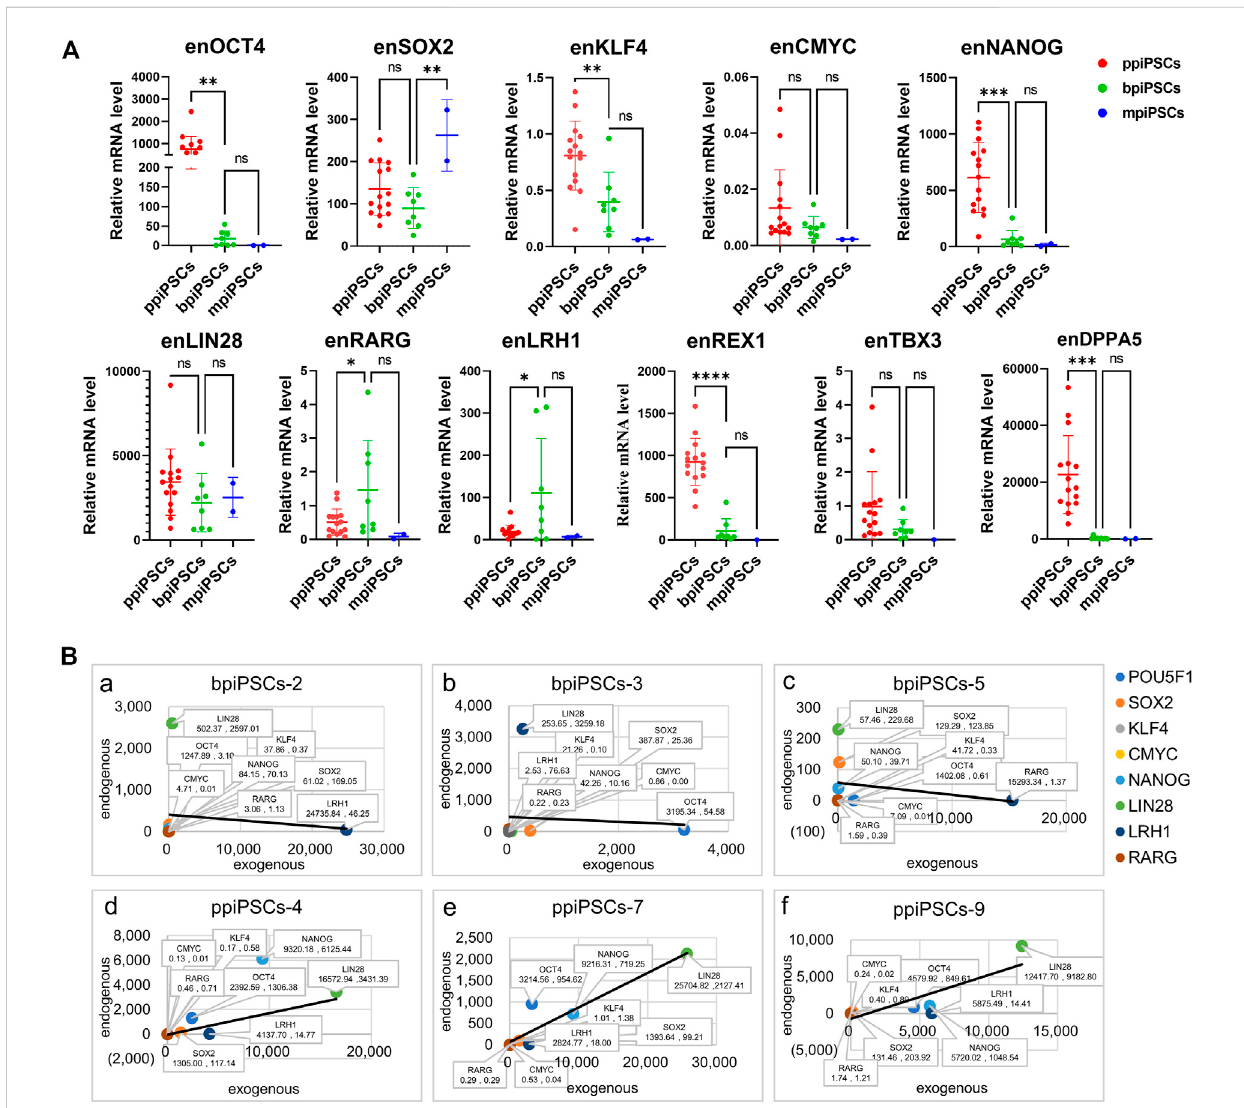
FIGURE 2 Comparison of endogenous pluripotency markers among the mpiPSCs, bpiPSCs and ppiPSCs and correlation analysis of endogenous and exogenous transcription factors. (A) qPCR analysis and comparison of endogenous pluripotency markers of OCT4 , SOX 2, KLF 4, CMYC , NANOG , LIN28 , LRH1 , RARG , TBX3 , REX1 and DPPA5 inppiPSCslines,bpiPSCslinesandmpiPSCslines.Dataaredepictedasmean±SD.* p < 0.05,** p < 0.01,*** p < 0.001, **** p < 0.0001, ns, no statistical signi fi cance. (B) Correlation analysis of the expression level between endogenous transcription factors and exogenous counterparts in piPSCs lines. a-c, bpiPSCs-2, 3 and 5; d-f, ppiPSCs-4, 7 and 9. The abscissa x represents the expression of exogenous transcription factors, and the ordinate y represents the endogenous counterparts. Data are presented in the form of (x,